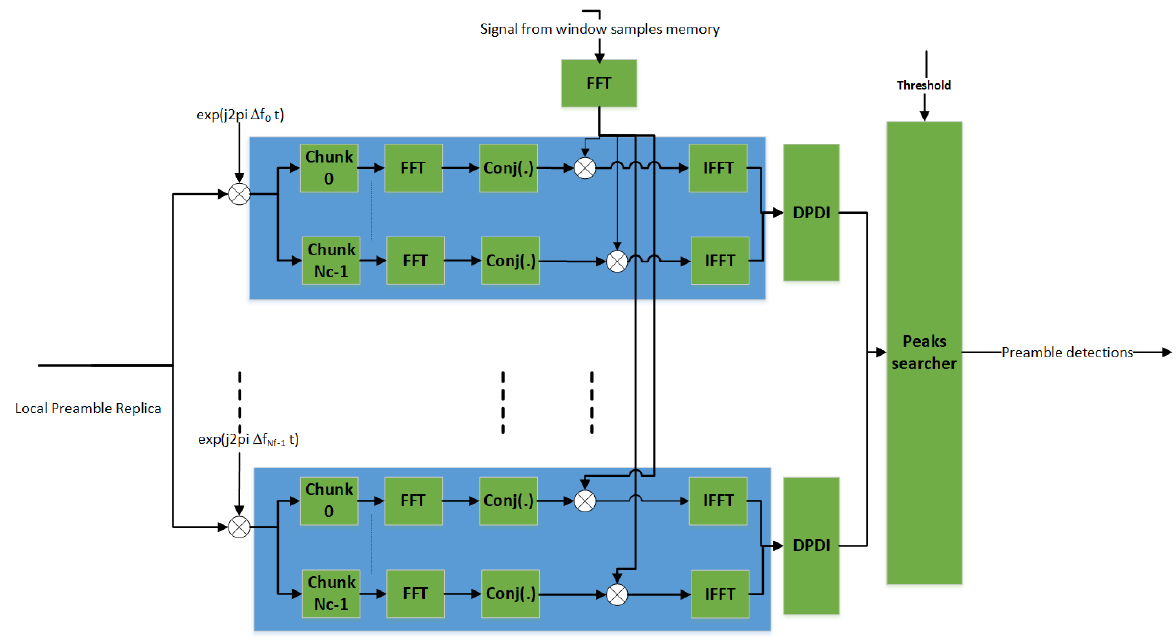
Figure 6. Non–coherent PS.